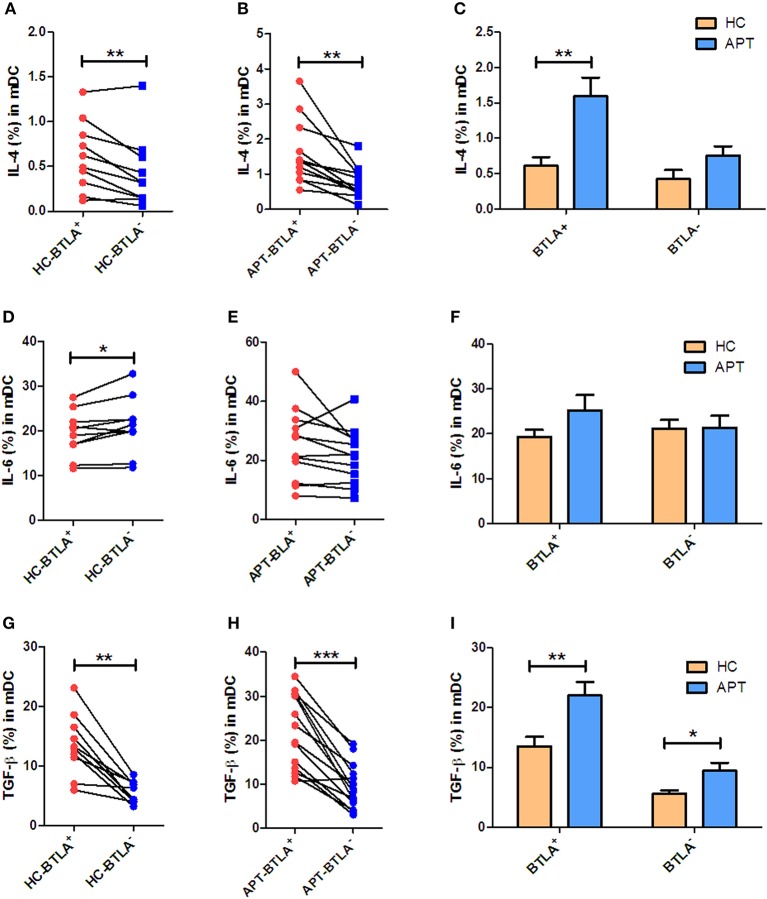
BTLA+ mDCs in active TB show an increased production of IL-4 and TGF-β compared with those from HCs. As IL-4, IL-6, and TGF-β produced by mDCs affect the polarization of Th cells, we sought to investigate whether BTLA expression affects IL-4, IL-6, and TGF-β production in mDCs. (A,D,G) show the mean frequencies of IL-4, IL-6, and TGF-β producing mDCs in BTLA+ and BTLA− DCs from HCs (n = 10). (B,E,H) show the mean frequencies of IL-4, IL-6, and TGF-β producing mDCs in BTLA+ and BTLA− DCs from TB patients (n = 12 or 14). (C,F,I) show the comparison of IL-4, IL-6, and TGF-β producing mDCs in BTLA+ and BTLA− mDCs between HC and APT patients, respectively. The P values are shown in each column (Student t-test). *P < 0.05, **P < 0.01, ***P < 0.001.